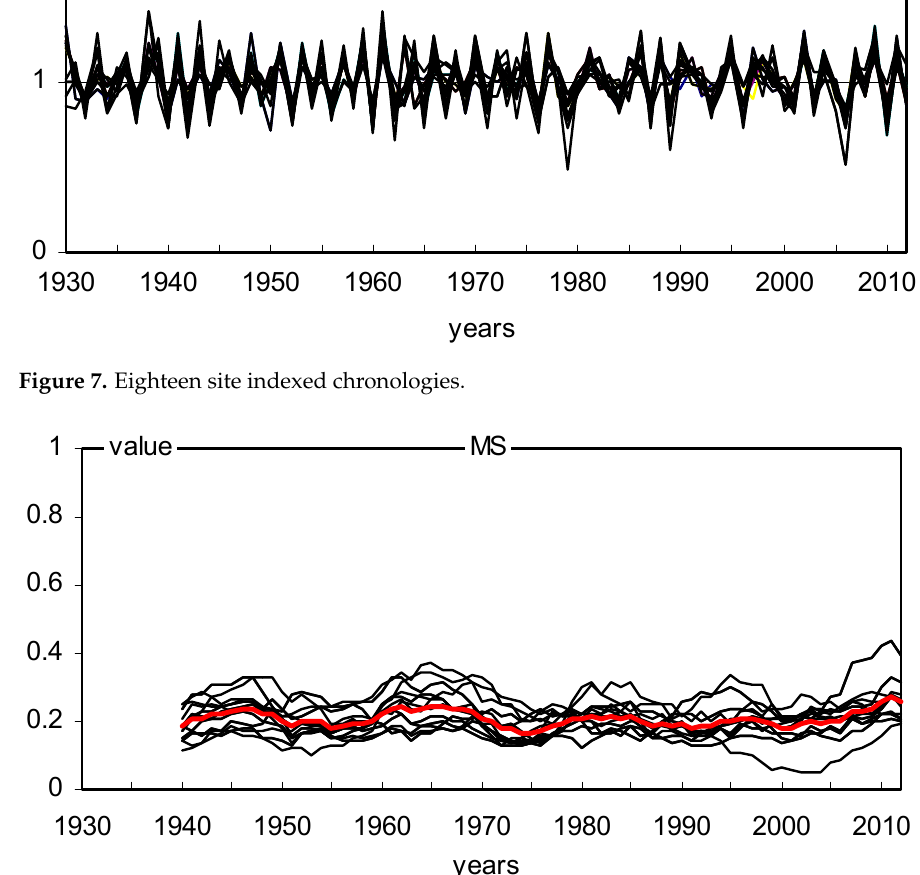
Figure 8. Ten-year running values of MS index. The consecutive MS values are plotted at the end of each 10-year period; the first period ranged from 1931 to 1940 and the last period from 2003 to 2012. The average MS values are marked with a red line.